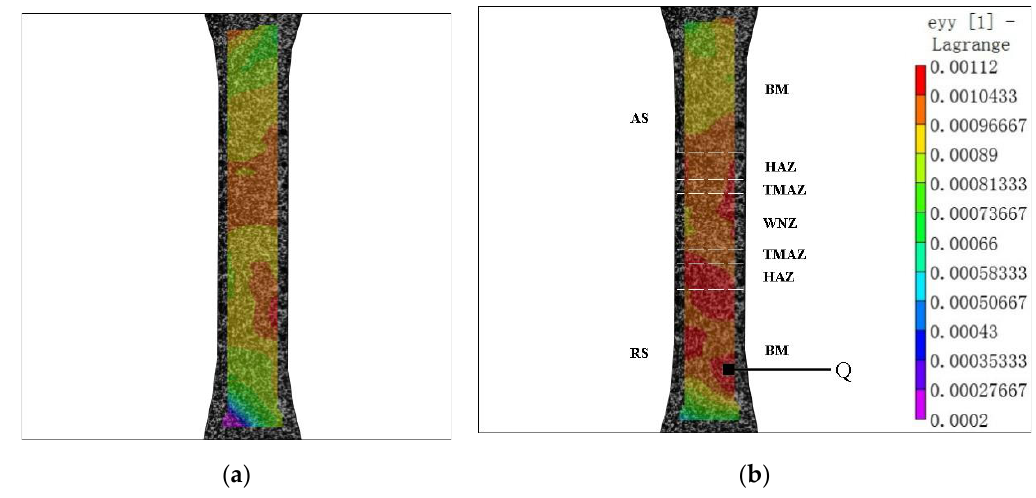
Figure 11. Strain distributions of specimen under stress ratio of −0 .3 at ( a ) 120,000 cycles, 55% of total life and ( b ) 218,000 cycles, 99% of total life.